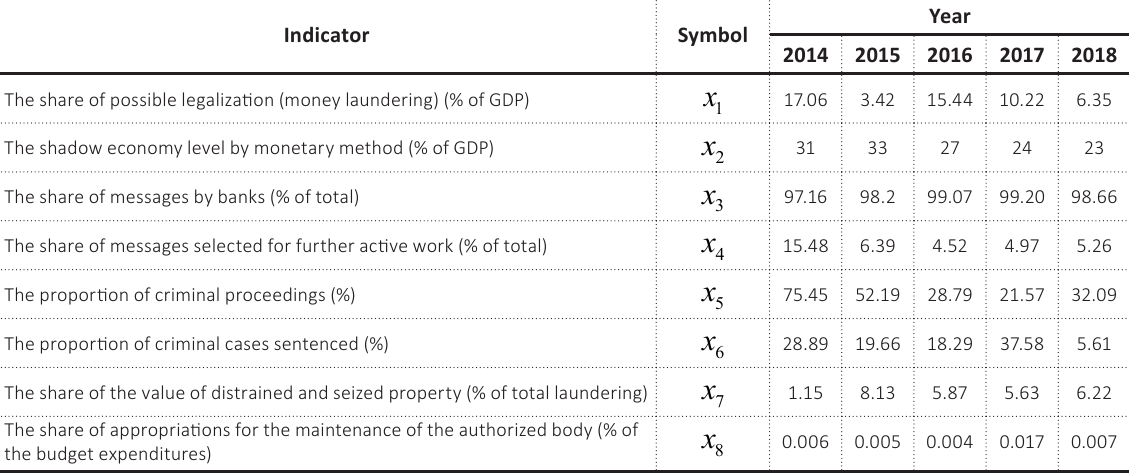
Table 1. Performance indicators of financial monitoring of the Ukrainian banking system in 2014–2018, % Indicator